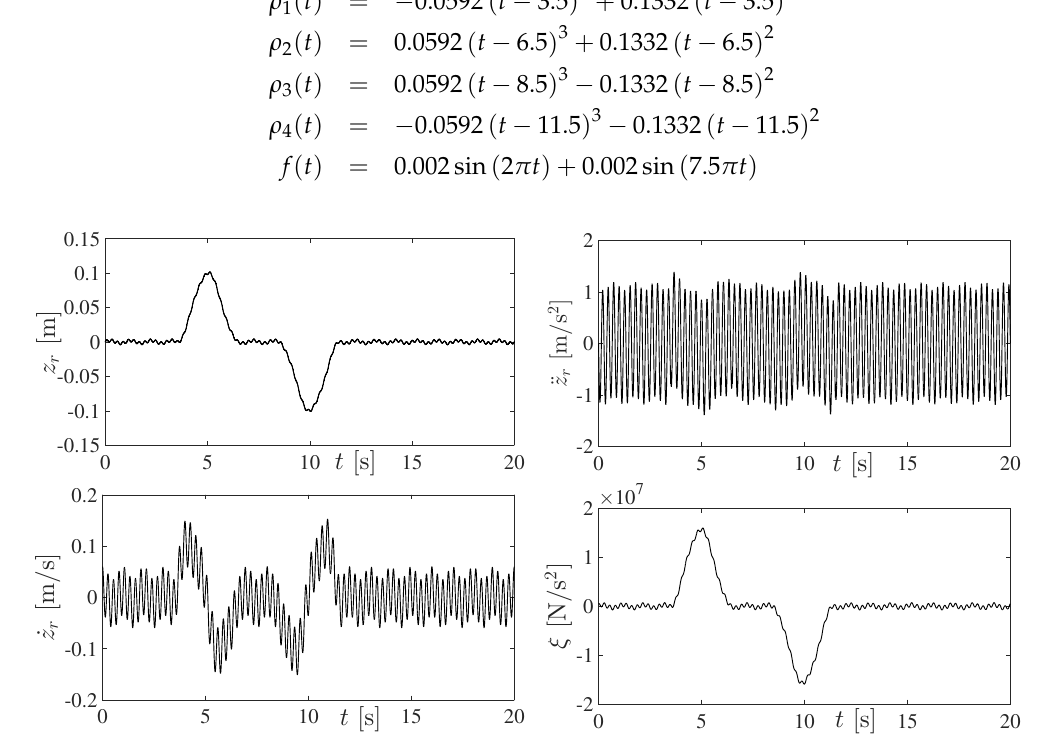
Figure 4. Disturbance trajectories induced by irregular road